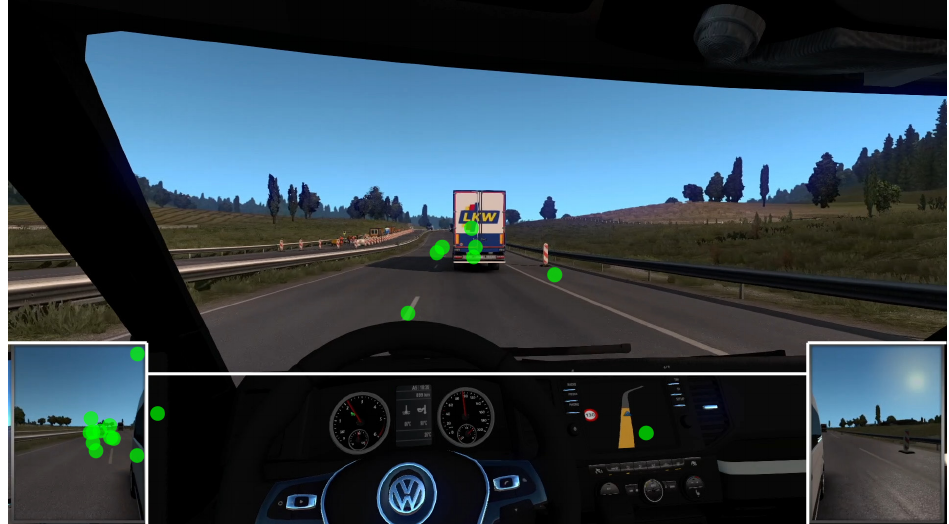
Figure 5. Moment in Video 3 where most participants attended to the left mirror (Baseline Task). The green markers represent the gaze coordinates of individual participants. White lines are drawn around the AOIs.